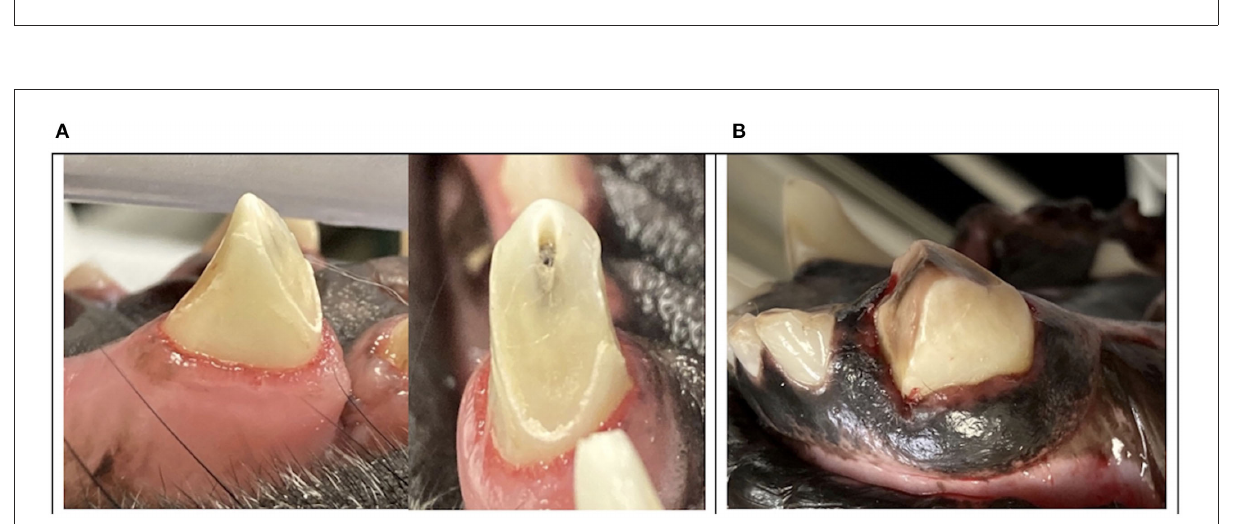
FIGURE12 Clinical photographs of trauma to the distal surface of canine teeth leading to catastrophic oblique crown fractures with propagation in the distal-mesial direction (A, B)